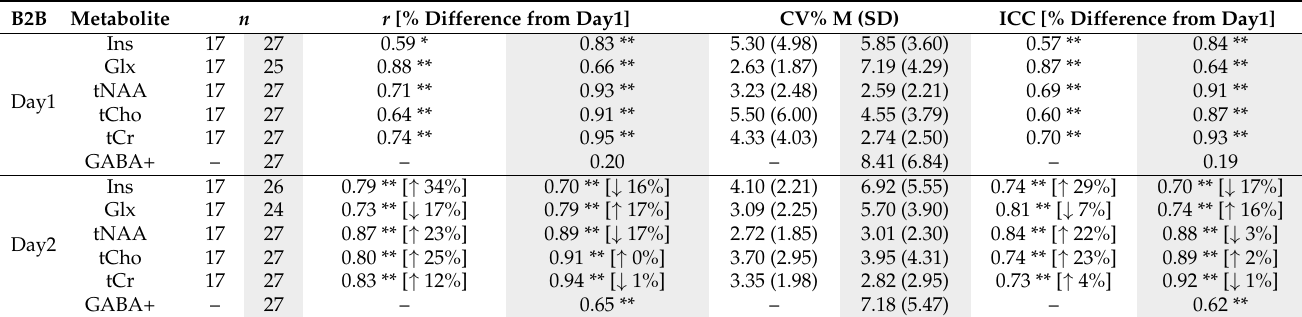
Table 2. B2B reproducibility metrics comparison: PRESS data (left white column) and MEGA-PRESS data (right grey column). CV% are quoted as mean (M) and standard deviations (SD) across all subjects. Large SD values result due to some very large outliers for CV%. Pearson’s correlation, r , and ICC values are denoted with */**, depending on the level of significance. Percentage changes (Day2 relative to Day1) for significant r and ICC values are shown in the square brackets.